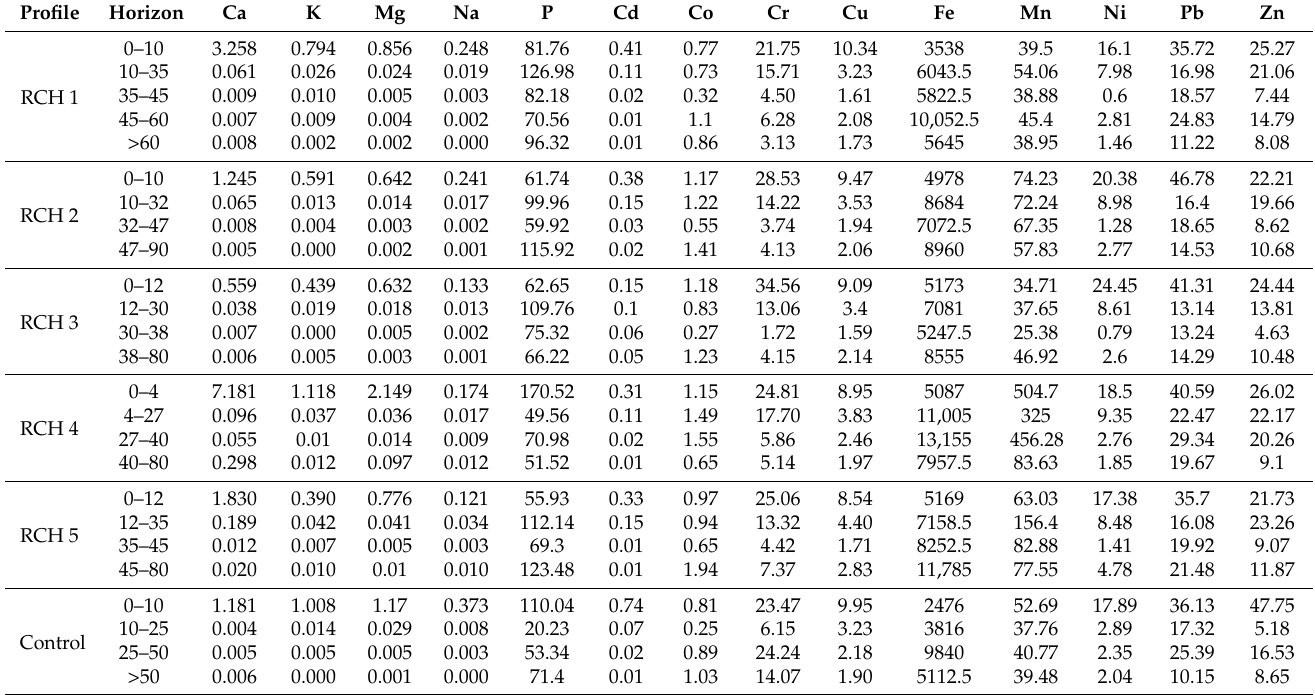
Table 2. Base cations content and microelements content in the examined soil